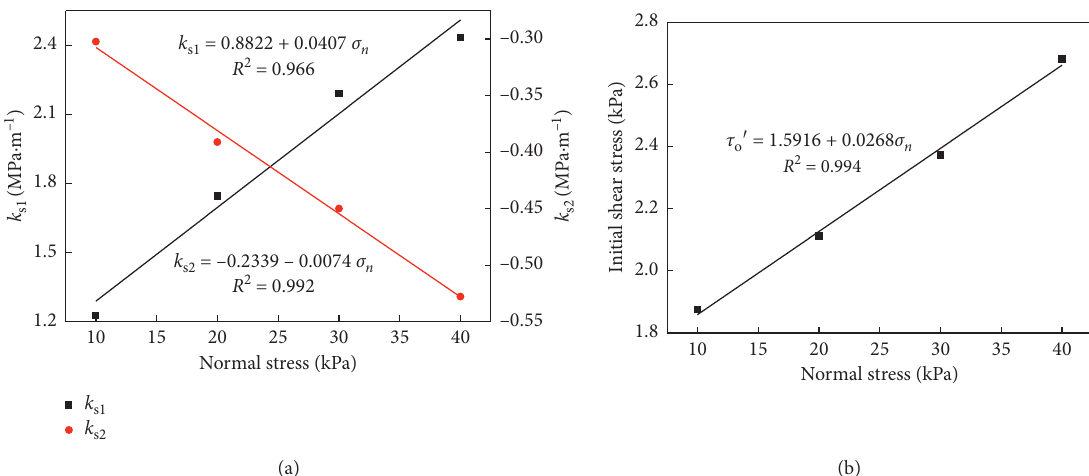
Figure 20: The relationship between the normal stress and the shear stiffness of the softening model: (a) shear stiffness and (b) initial shear